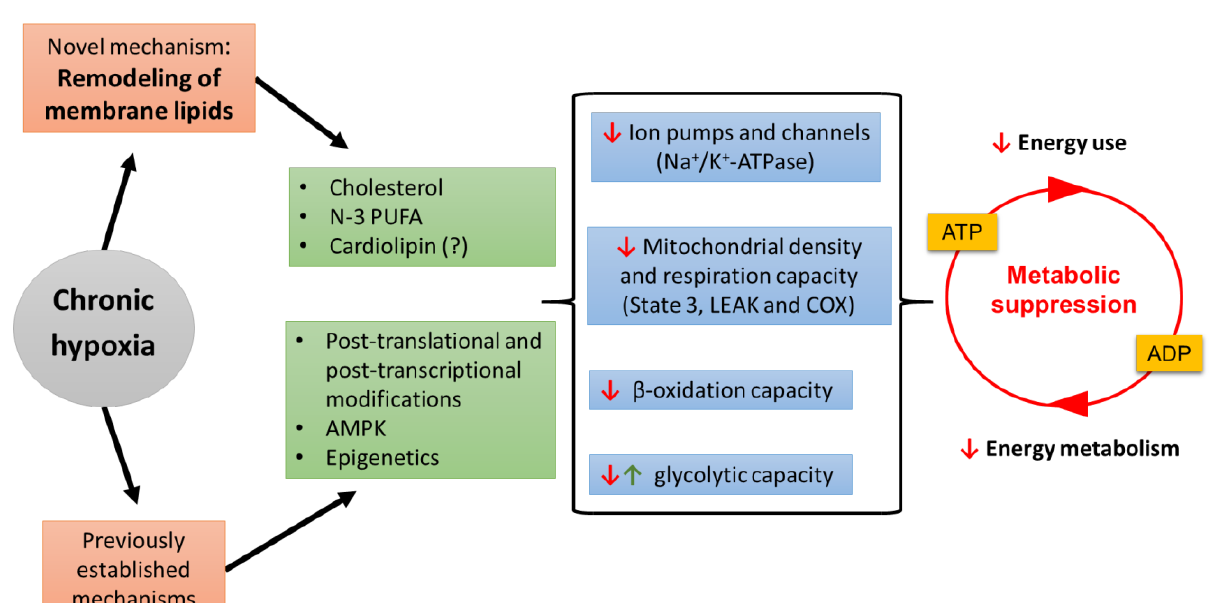
Figure 3. Remodeling of membrane lipids is a proposed new mechanism to promote metabolic suppression in chronic hypoxia. Prolonged in vivo exposure to low oxygen alters the relative abundance of membrane cholesterol, n-3 polyun- saturated fatty acids (PUFA), and possibly mitochondrial cardiolipin in ways that downregulate ion pumps such as Na + /K + -ATPase (a major ATP consumer), ion channels, and possibly mitochondrial respiration capacity [state 3 (OXPHOS in the presence of substrates and ADP) and LEAK (proton leak)]. Chronic hypoxia also causes a general reduction in cytochrome c oxidase (COX) indicating a decrease in mitochondrial density. The observed changes in membrane compo- sition are known to modulate metabolic pathways of energy metabolism such as β -oxidation (downregulation) and gly- colysis (up or downregulation). Reduction of flux through the ATP-ADP cycle can also be induced by previously charac- terized mechanisms that involve post-translational/post-transcriptional modifications [11] , 5′ -AMP-activated protein ki- nase (AMPK) [12] or epigenetic changes [13]. Membrane remodeling and established mechanisms work in concert to cause metabolic suppression.